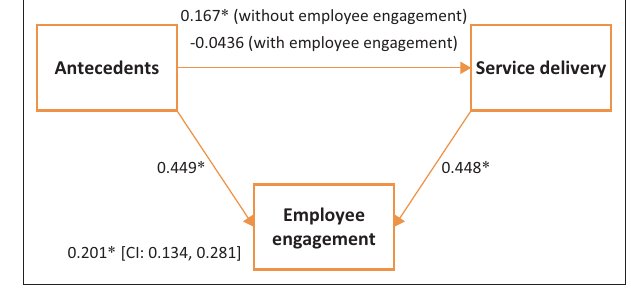
FIGUR E 2: Mediation